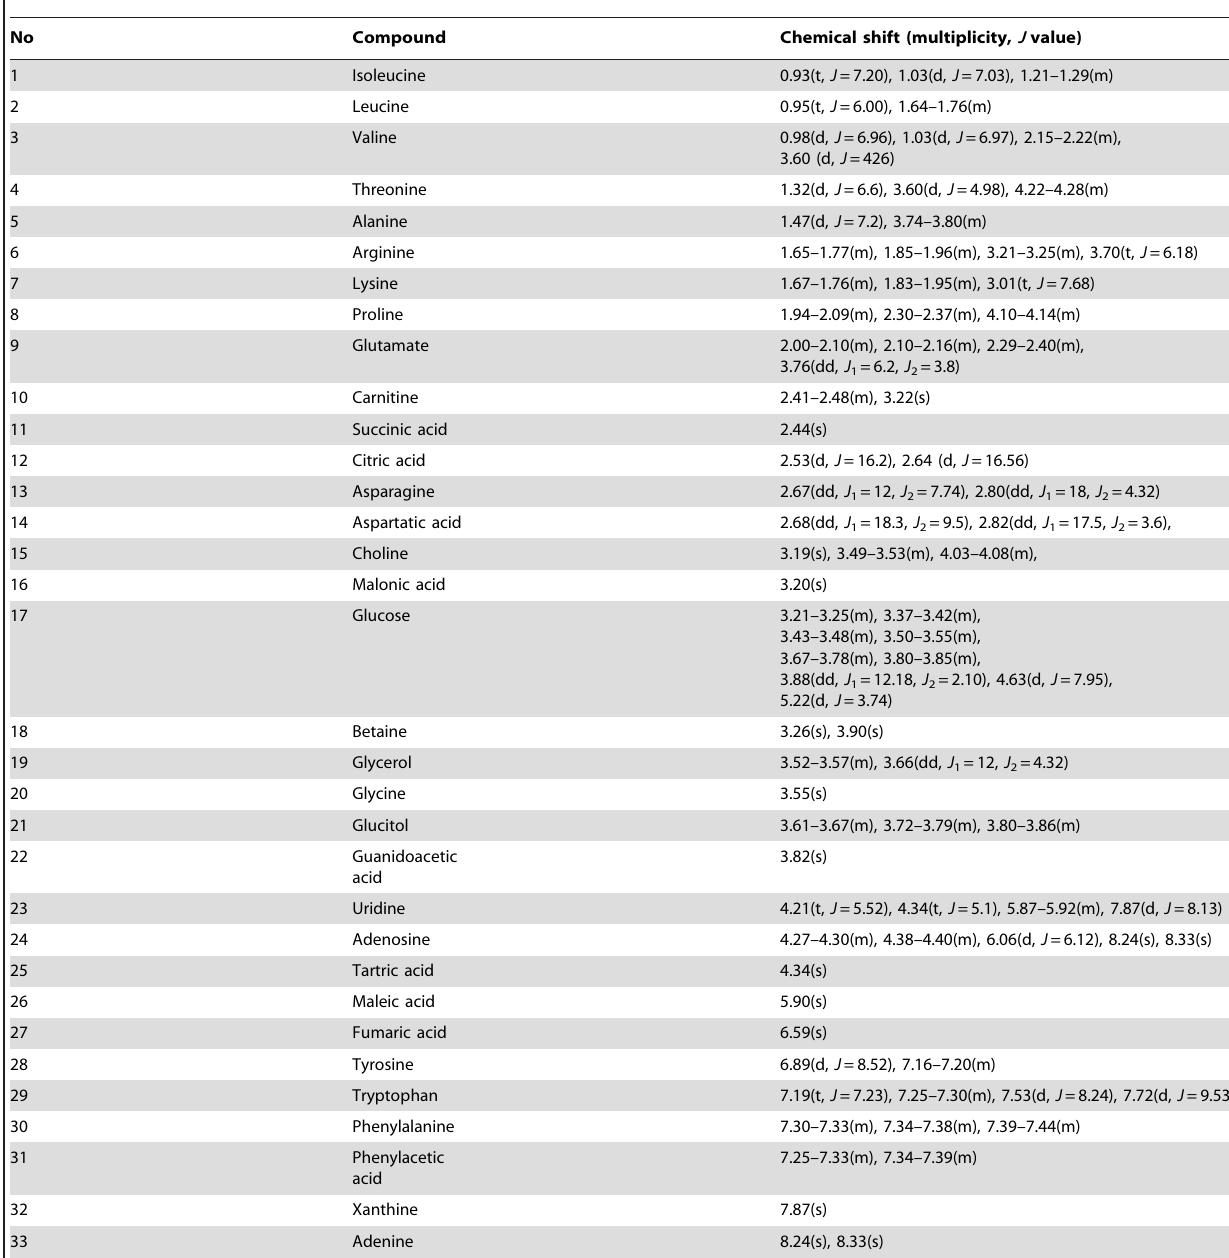
Table 2. Assignment of 1 H NMR spectral peaks for C. pruinosa mycelia using D 2 O extracts.